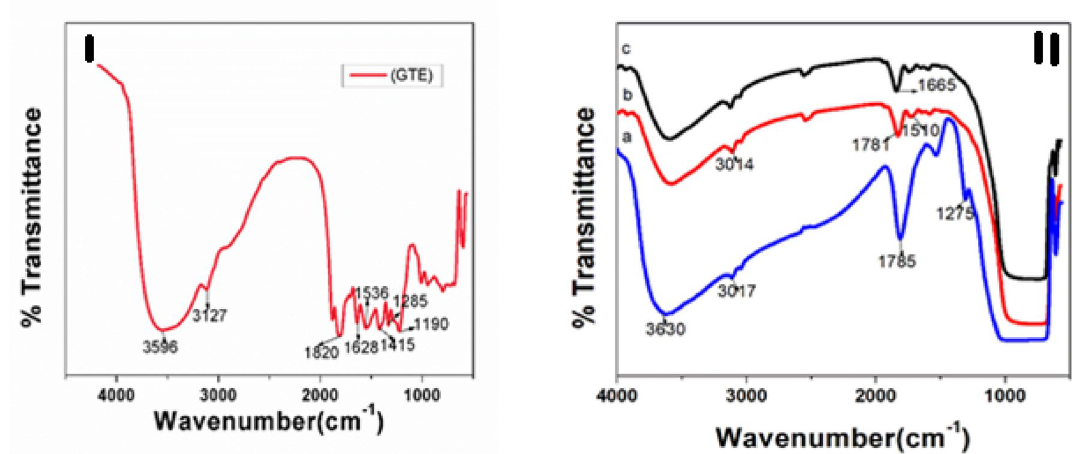
Figure 4. FT-IR spectrum of ( I ) tea extract, ( II )a As-synthesized NT1, ( II )b Calcined NT1, ( II )c Calcined